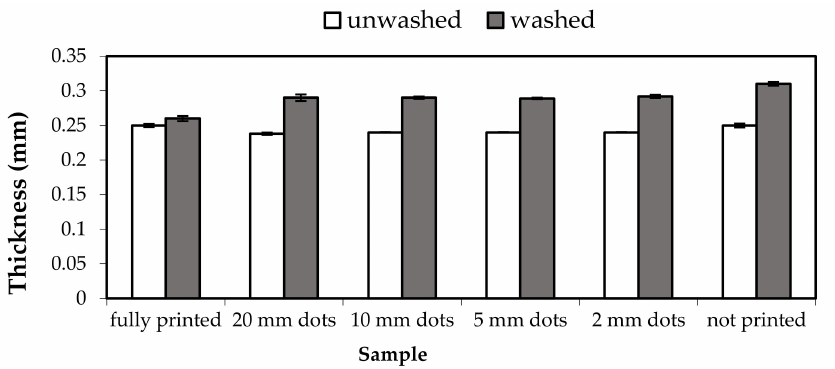
Figure 5. Thickness of samples printed without pattern, samples printed by pattern (dots) and of not printed sample.